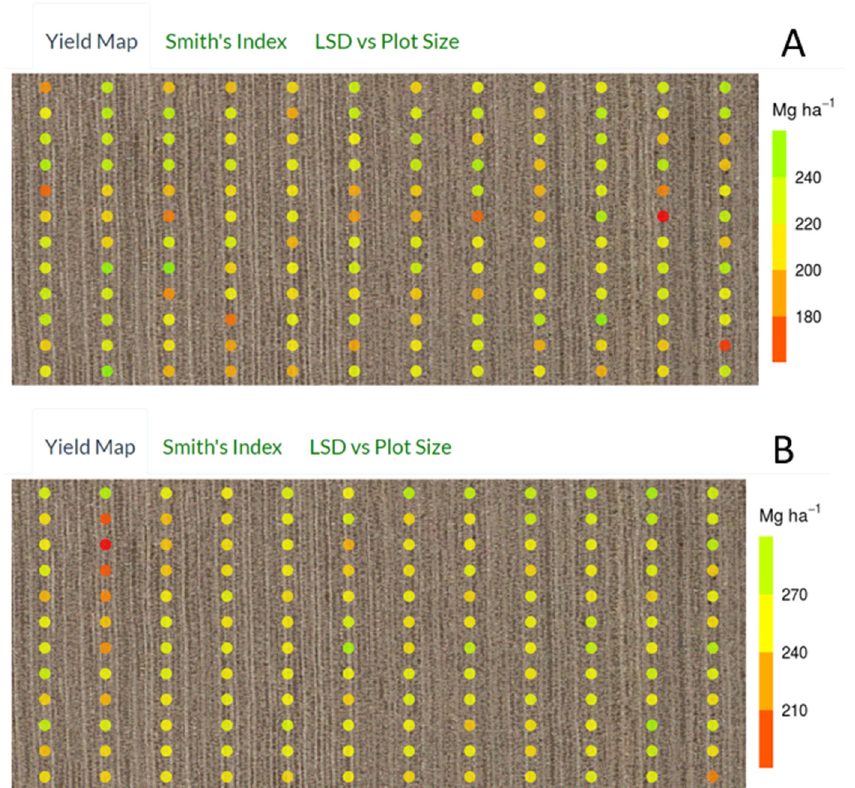
Figure 5. Output from a Shiny application to automate data compilation for uniformity trials. The output data include a plot map with horizontal and vertical coordinates and points colored according to relative yield. Fields ISU.B4 ( A ) and ISU.SE ( B ) are used in this example. Relationship of Variance and Plot Size. Available online: https://marin-harbur.shinyapps.io/plot_size_app_for_uploaded_data/ (accessed on 18 June 2021).